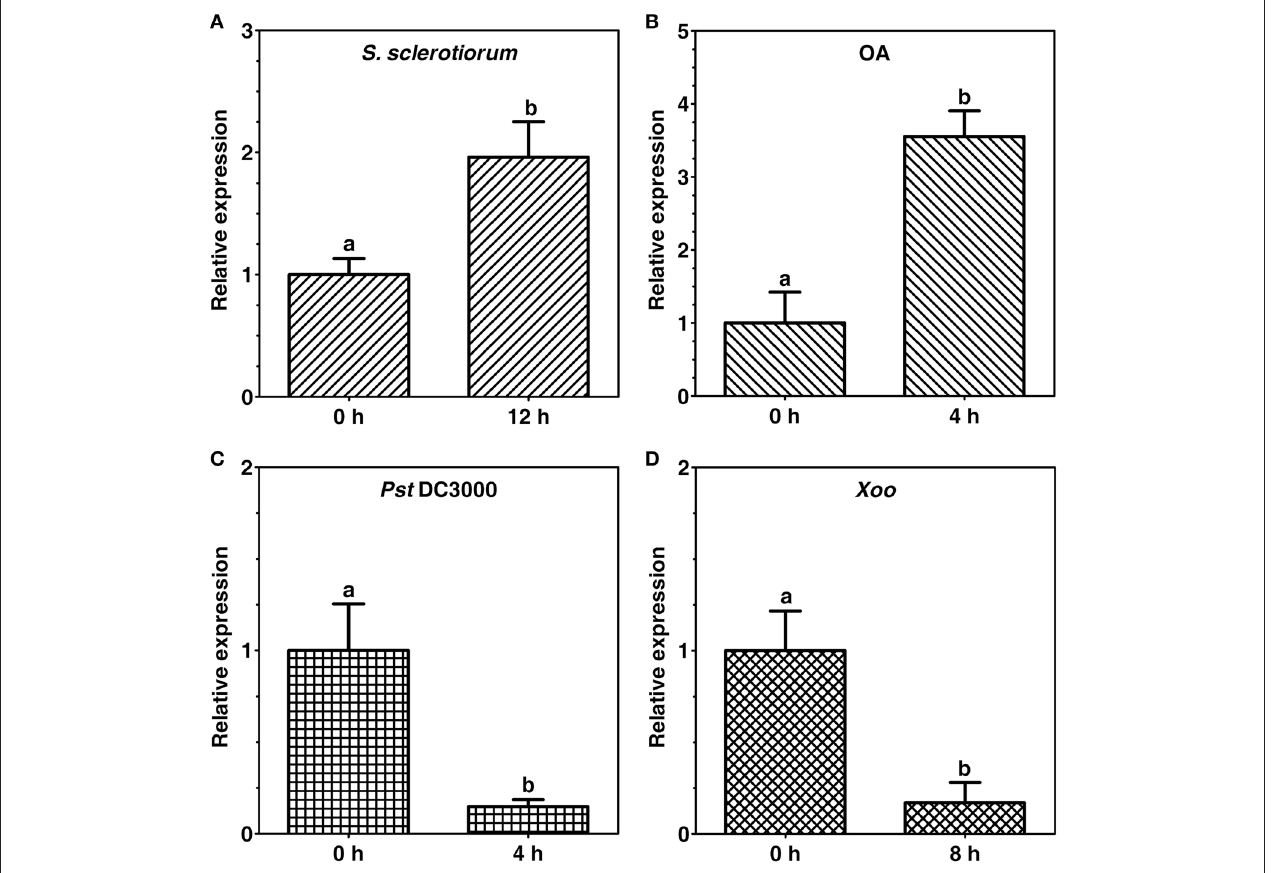
FIGURE 5 | Expression patterns of the SlCCaMK gene in response to pathogen inoculation and pathogenecity factor treatment. Gene expression was analyzed at 12h after S. sclerotiorum inoculation (A) , 4h after OA treatment (B) , 4h after Pst DC3000 infiltration (C) , and 8h after Xoo infiltration (D) . The small letters indicate the signicant difference of the SlCCaMK gene expression under each stimulus ( P ≤ 0.05, by Student’s t -test).